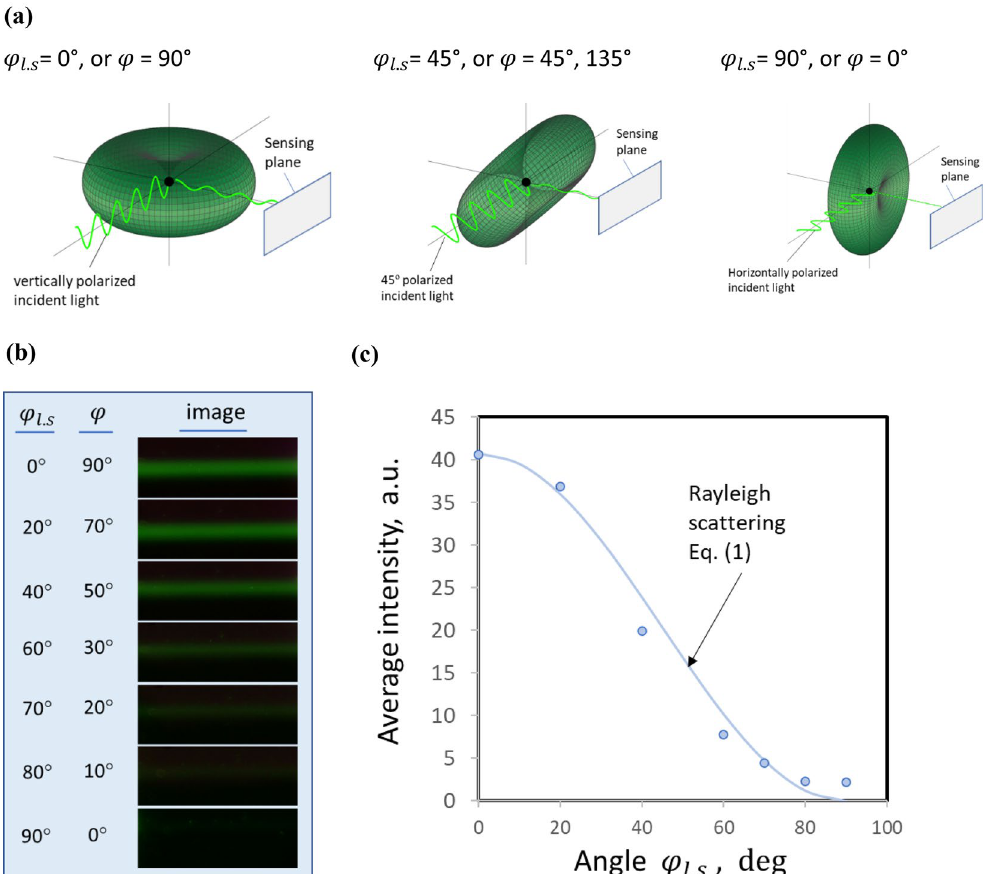
Figure 4. Effect of the angle ϕ l.s between the incident light polarization plane and the sensing plane . ( a ) The change of the induced light scattering profile with the incident light wave oscillation plane, or the incident light polarization plane, at several positions marked with corresponding ϕ l.s and ϕ . ( b ) Change of brightness of light scattering image with the angles ϕ l.s or ϕ . ( c ) The plot of average intensity per sensing pixel extracted from the light scattering images shown in (b) as a function of the angle ϕ l.s , as well as a curve calculated based on Eq.